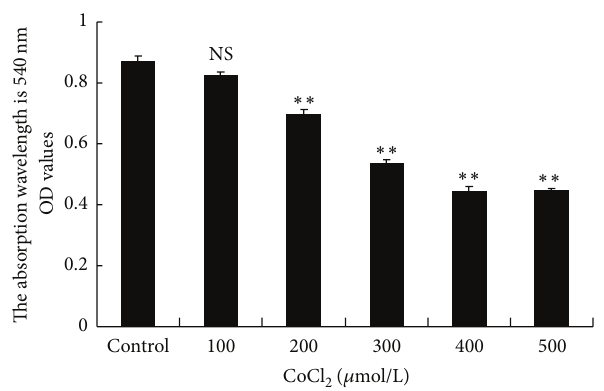
Figure 1: Effect of CoCl 2 with various concentrations on cell viability of RF/6A model cell. ∗∗ 𝑃 < 0.01 indicates comparison with control group.